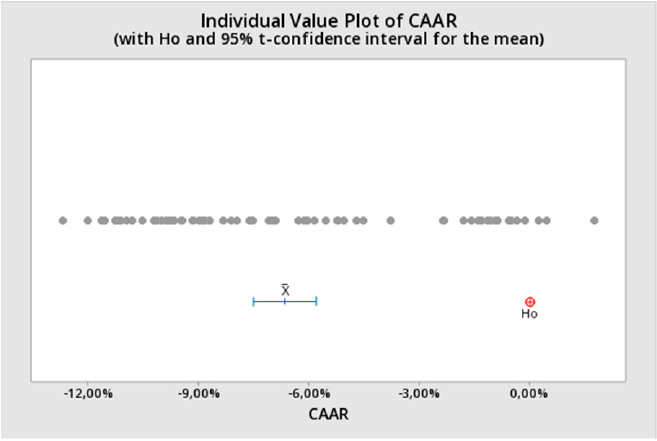
Figure 2. t -Test histogram of CAAR for E ( − 40,+40).